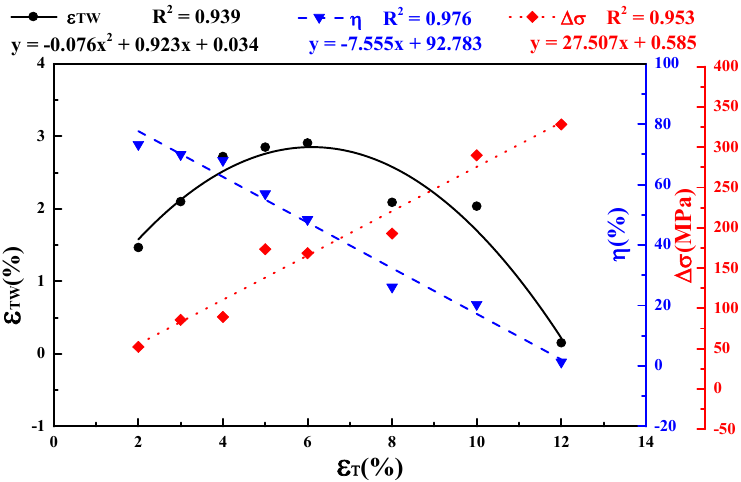
Figure 8. Effects of ε T on the ε TW , ∆ σ and η of columnar-grained Cu 71.7 Al 18.1 Mn 10.2 alloy samples.